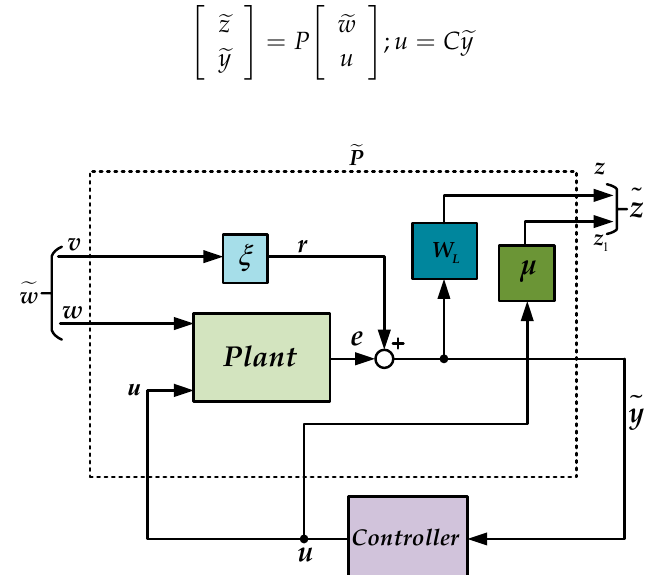
Figure 4. Formulation of the H ∞ control problem.